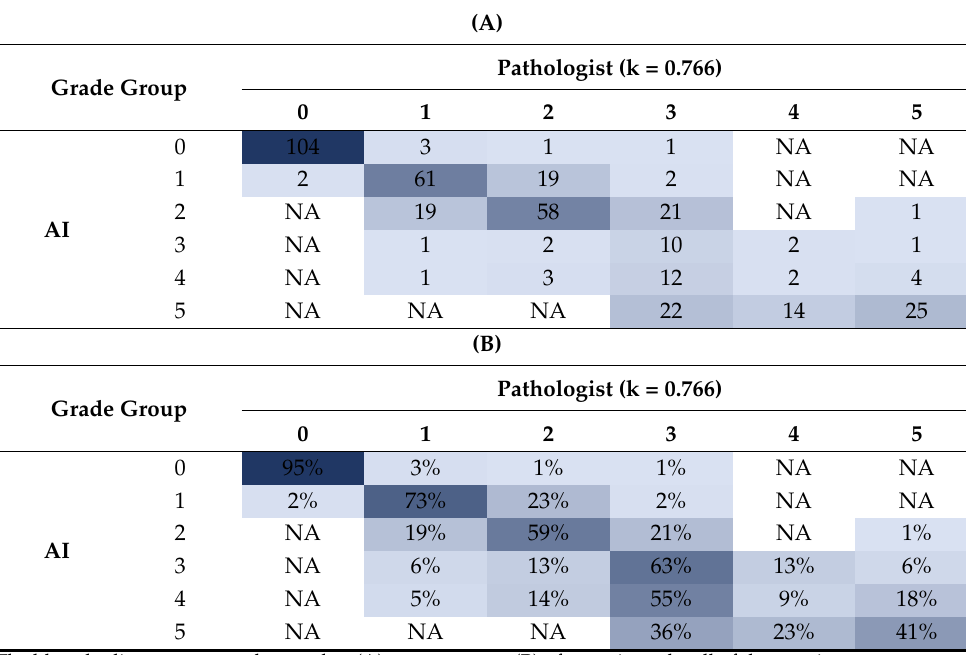
Table 5. Accuracy of the AI algorithm: Predictive values for all classes.